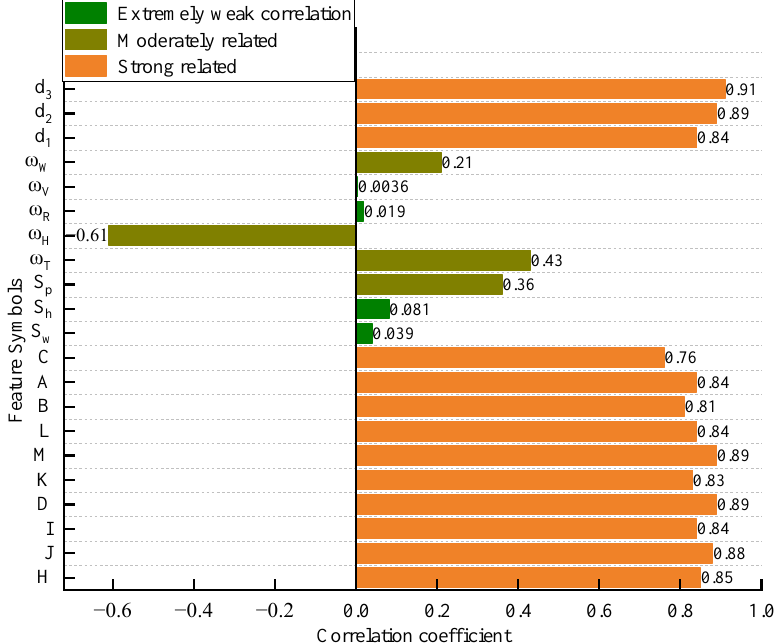
Figure 5. Feature correlation analysis chart.